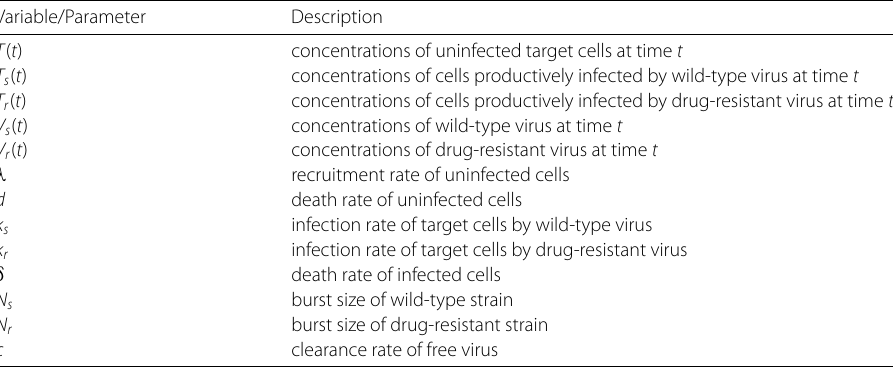
Table 1 Biological significance of variables and parameters Variable/Parameter